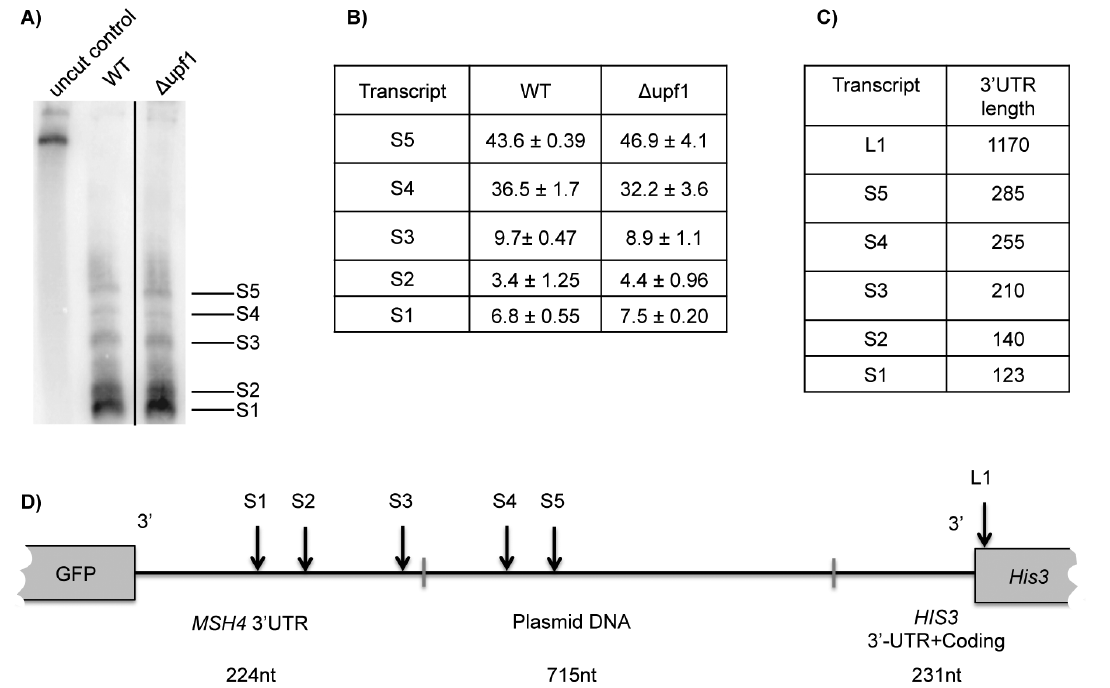
Figure 4. Five short transcripts are not targets of NMD. ( A ) After treatment with RNase H the shortest transcript observed on a 1% agarose gel can be resolved into 5 distinct bands on a 6% polyacrylamide gel. ( B ) Relative accumulation of the five short transcripts. Values in WT and D upf1 columns represent each transcript as a percentage of the sum of the first five transcripts. ( C ) Sizes of all observed transcripts from northern blots performed on polyacrylamide gels (transcripts 1-5) and agarose gels (transcript B). Sizes were determined based on a combination of RT-PCR and estimates based on relative migration in gels to known size markers. ( D ) Schematic representing the transcription products of the GFP-MSH4 3 9 UTR construct (not to scale). The plasmid DNA fragment is 710 bases and contains prokaryotic DNA. The HIS3 gene is located on the crick strand relative to the GFP coding region.